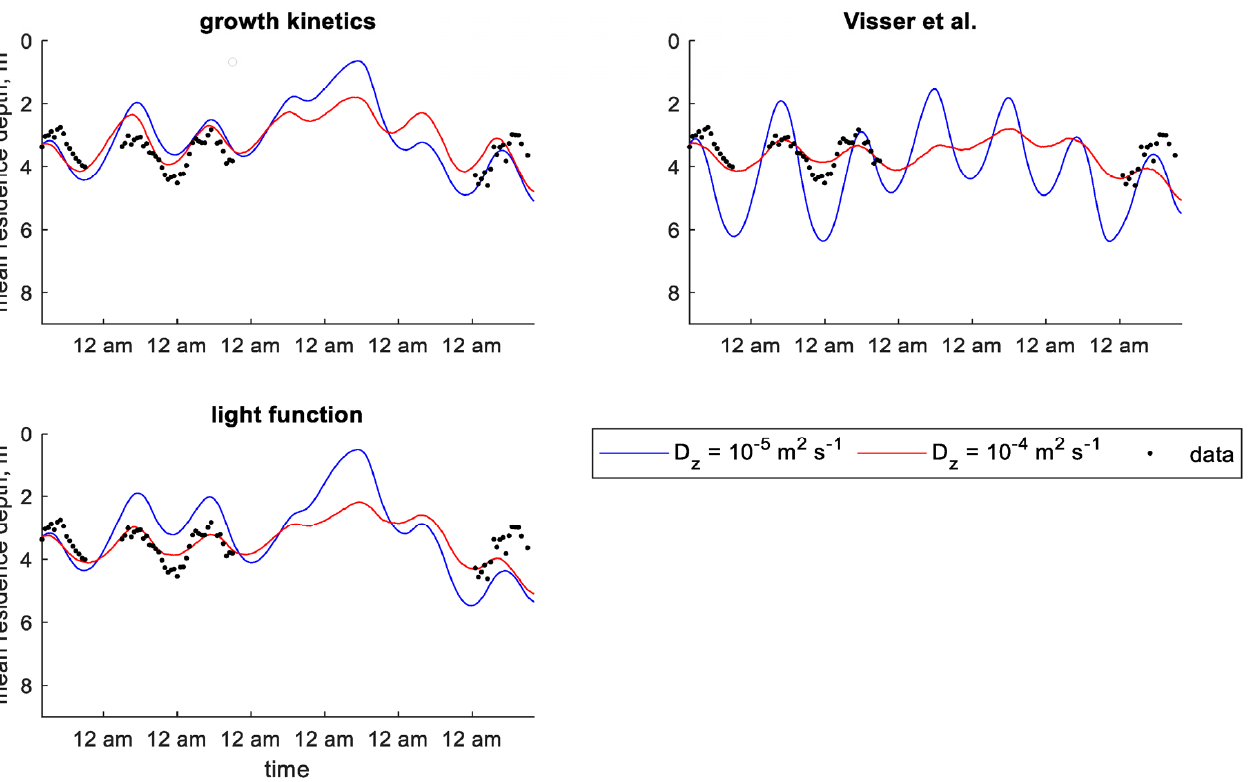
Figure 9. Time series of observed and predicted mean residence depth of chlorophyll a concentration in Xiangxi Bay using dynamic velocity models (particle-tracking)